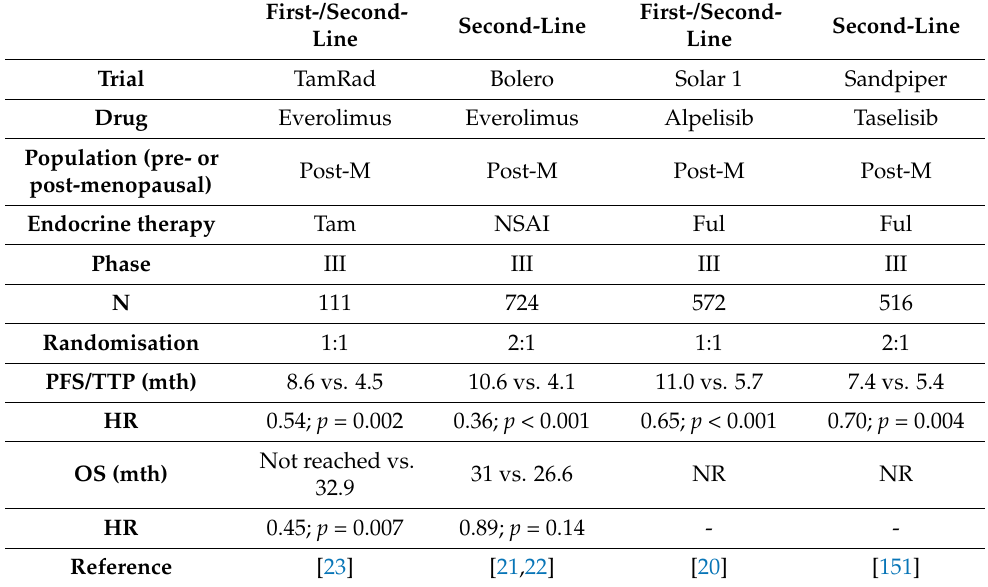
Table 4. Seminal trials of PI3Ki and mTORi + endocrine therapy in advanced breast